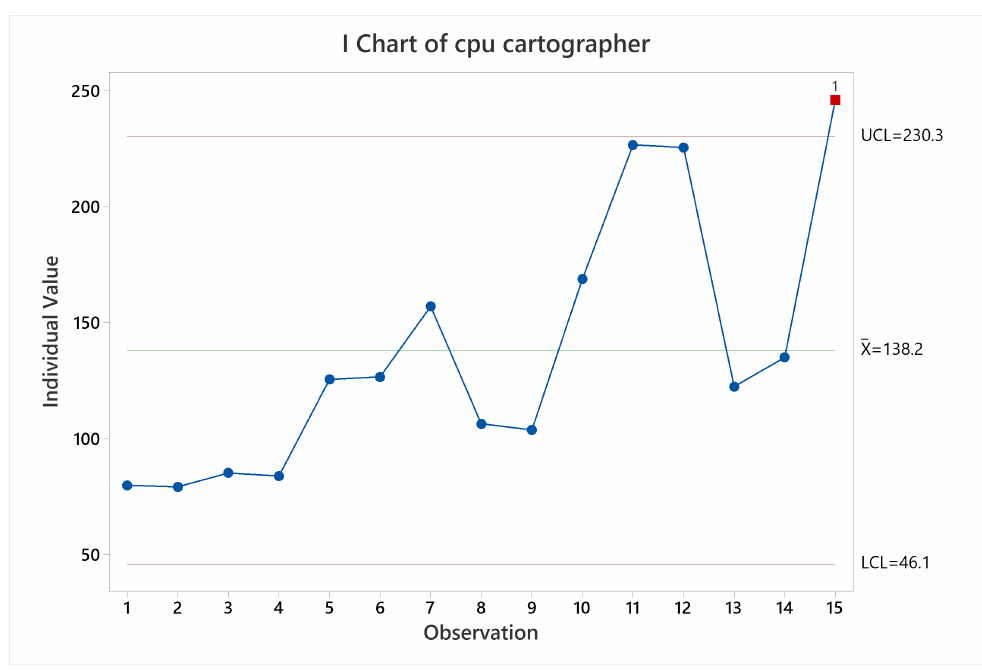
Figure 12. CPU usage mean behavior for Cartographer.